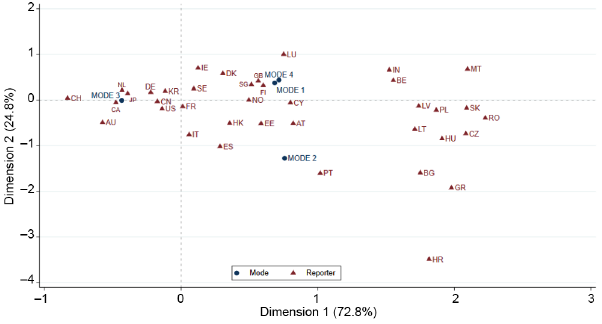
Figure 2. Service exports by mode and by country, 2017 (source: WTO mode of supply dataset, authors’ elaborations (Figure 2), CA results in a two-dimensional plot with 38 points corresponding to the coun- tries and 4 points corresponding to the modes of supply. In the plot, any two countries A and B are close to each other if their profiles are similar. At the same time, country A is close to